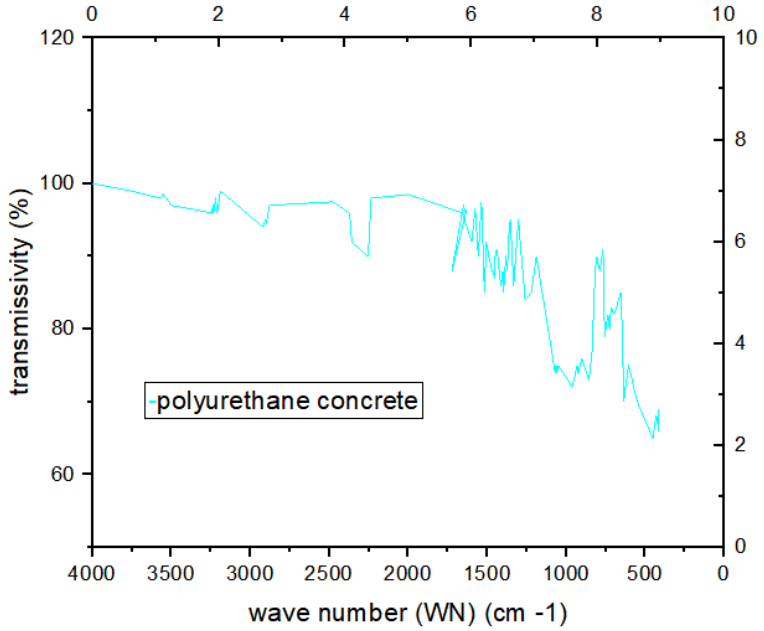
Figure 11. IR test graph of polyurethane concrete. Table 6. Categories of functional groups represented by the peaks in the IR test graph of polyure- thane concrete.